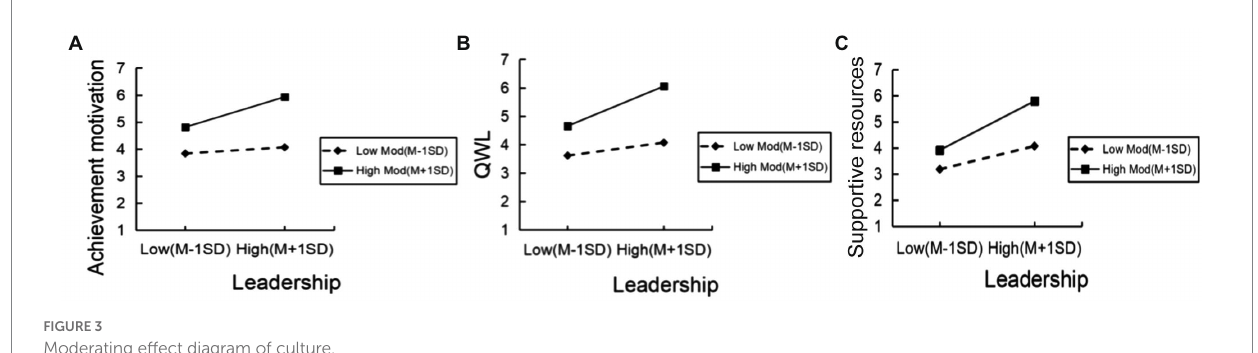
FIGURE 3 Moderating effect diagram of culture.